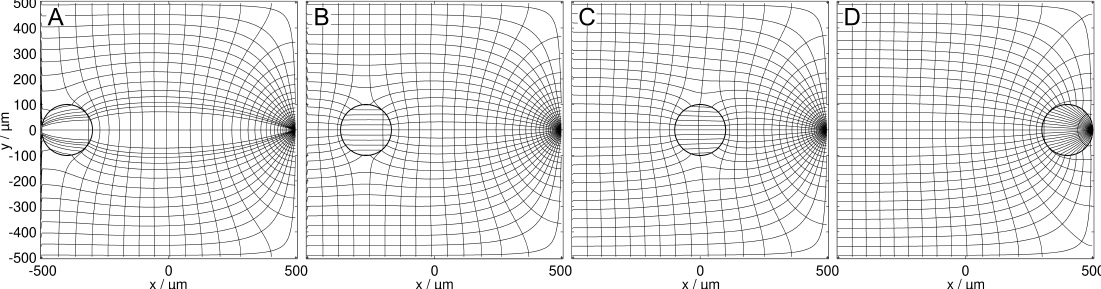
Figure 3. Potential and current line distributions for different positions of the 1.0 S sphere in 0.1 S medium, in front of the plain electrode ( A ), on the watershed ( B ), in a largely homogeneous field region ( C ), and at the pointed electrode ( D ). The conductances are ( A ): 35.744 mS, ( B ): 35.563 mS, ( C ): 35.647 mS, and ( D ): 83.912 mS. The basic sheet conductance L 2 D corresponds to a cell constant of k 2 D =